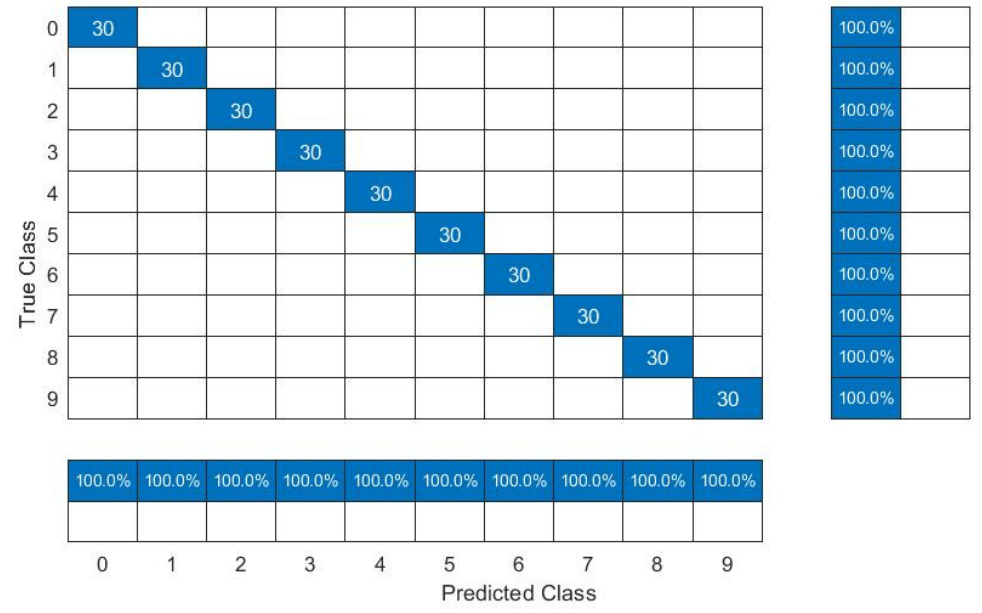
Figure 9. Confusion chart of the proposed method for unseen testing data (largest training dataset).